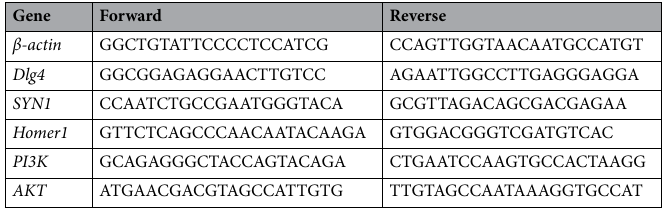
Table 1. Primers used for q-PCR in this